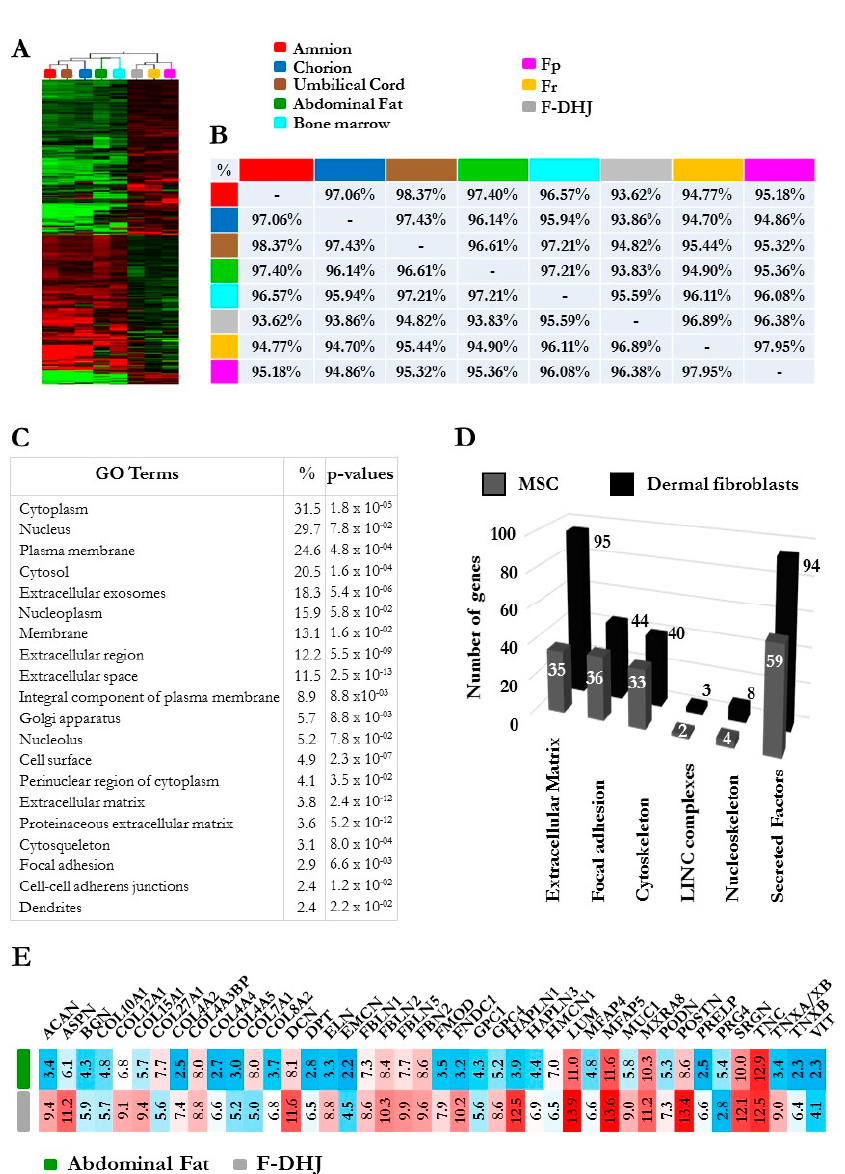
Figure 7. Comparative microarray transcriptome profiling of the three fibroblasts populations (Fp, Fr, and F-DHJ) and mesenchymal stem cell (MSC) samples corresponding to five sources (bone marrow aspirates, adipose tissue, amnion, chorion, and umbilical cord jelly). ( A ) Hierarchical clustering of fibroblast and MSC samples based on the 380 most discriminant probe sets showing a marked distinction between the “fibroblast” and “MSC” groups. ( B ) Pearson correlation coefficients evaluating sample-to-sample proximity based on comparisons of global transcriptome profiles. Notably, this analysis showed the low proximity between F-DHJ with adipose tissue MSCs (93.83% similarity) and high proximity with Fr fibroblasts (96.89% similarity). ( C ) List of the 20 most significant gene ontology (GO) terms differentiating the “fibroblast” and “MSC” groups based on 2974 probe sets (1984 transcripts) exhibiting differential signals (fold-change > 2 and p < 0.05). ( D ) Signatures identifying the “fibroblast” group (black bars) and the “MSC” group (grey bars) among transcripts related to the tissue skeleton biology (fold-change >2 and p < 0.05). ( E ) Focus on 42 transcripts directly involved in the structuration and composition of the ECM network and identified within the signature that distinguishes the “fibroblast” and “MSC” groups. Values were obtained by GCRMA microarray signals and corresponded to an indication of transcript levels (arbitrary units) in F-DHJ and adipose MSCs.